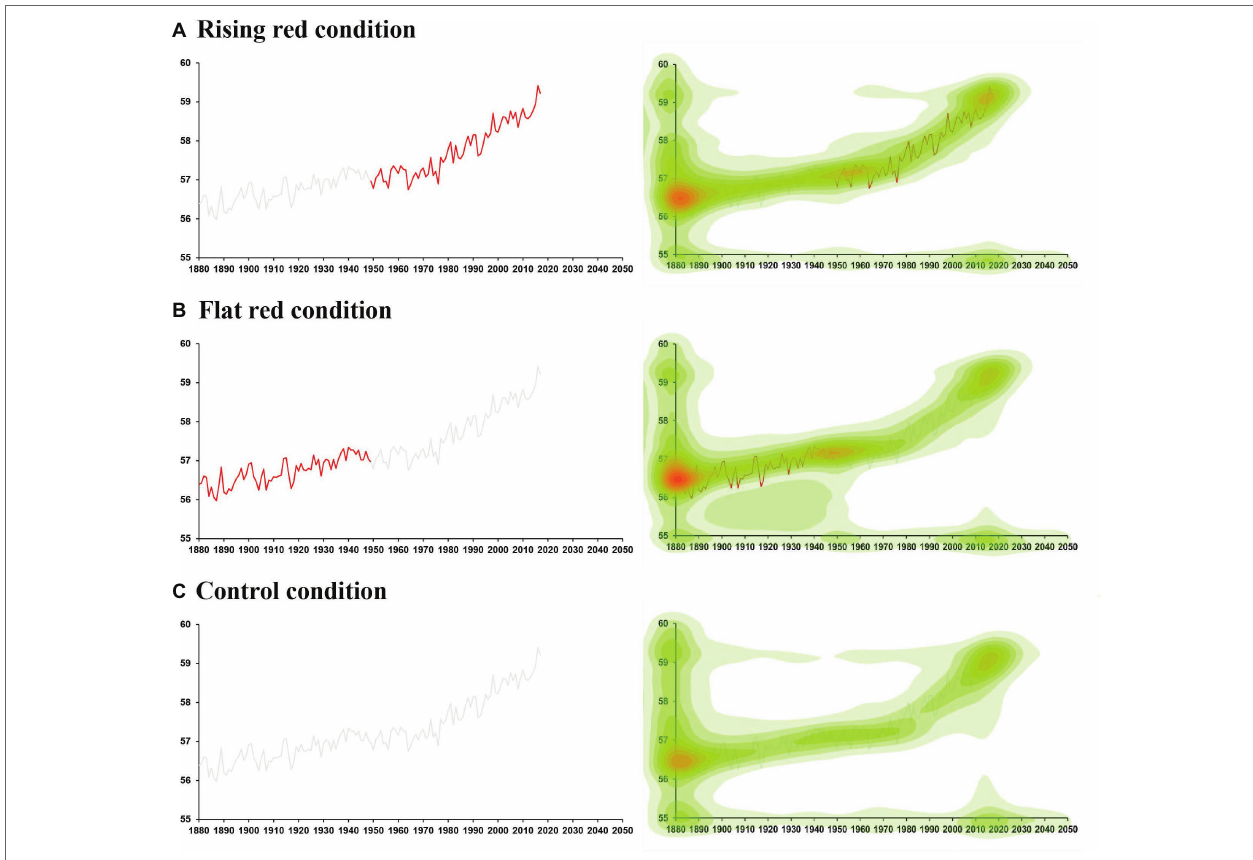
FIGURE 6 | Experiment 3. (A) In the rising red condition, the rising phase from 1950 to 2017 was highlighted in red. (B) In the flat red condition, the flat phase from 1880 to 1949 was highlighted in red. (C) In the control condition, both rising and flat phases were in gray. A heatmap representing the distribution of the average density of mouse location on the graph is shown on the right side in each condition. Warmer colors represent higher average density of mouse location.